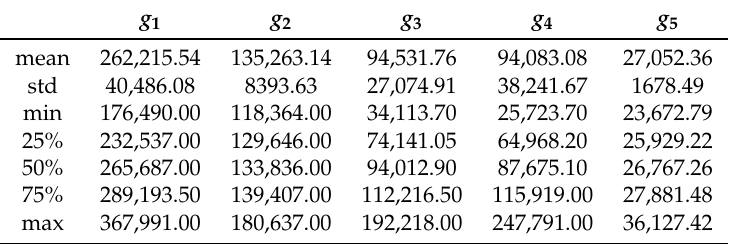
Table 2. Overview of the resulting cost values for the 4667 Pareto-optimal solutions. Groups g 1 , . . . , g 4 are weighted sums of the criteria depicted in Table 1. g 5 represents the lengths of the paths and thus equals o 25 (see Table 3). Note: g 1 is a bundling criterion and thus represents the accumulated lengths along which no linear infrastructure corridors are crossed.